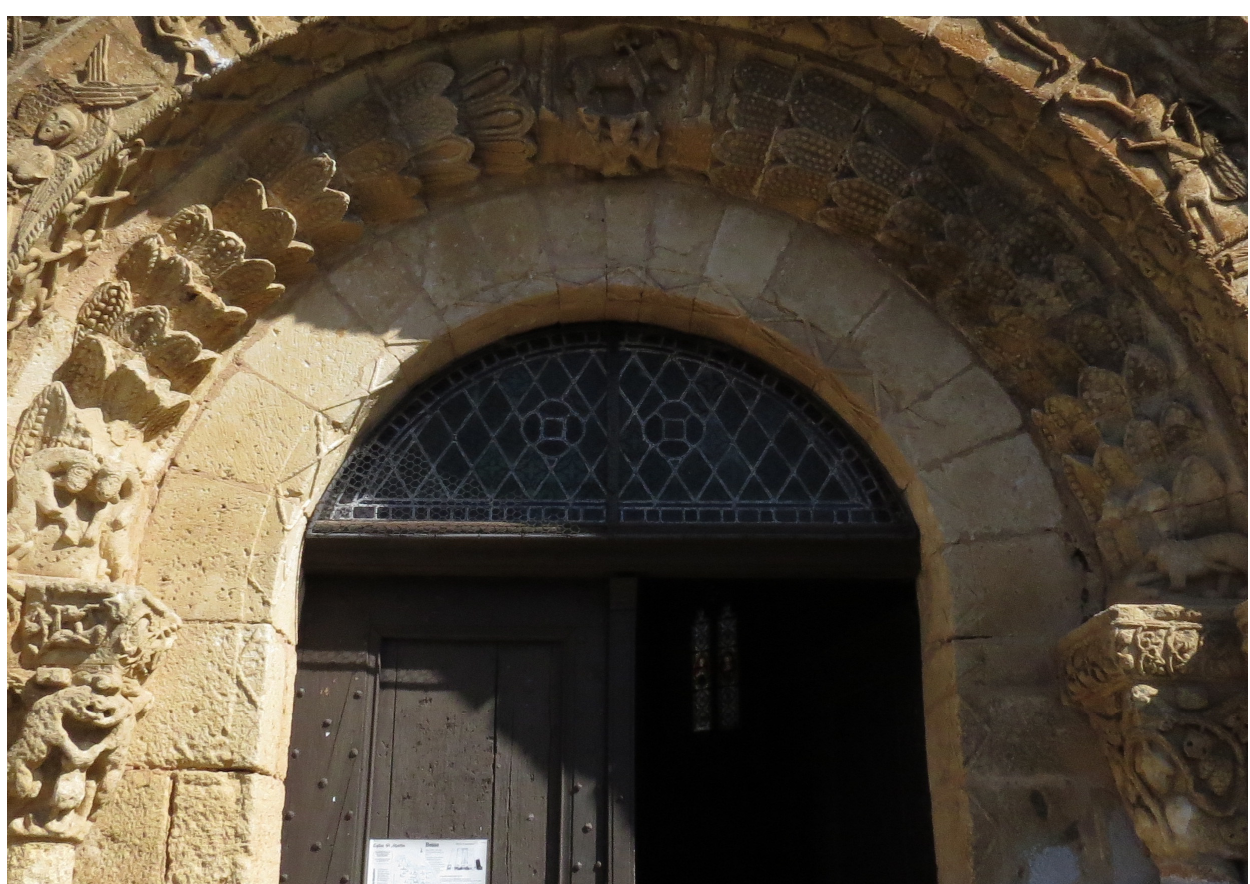
Figure 10. Palm-tree ribbons and door frame, detail of archivolt, west façade, Saint-Martin Church